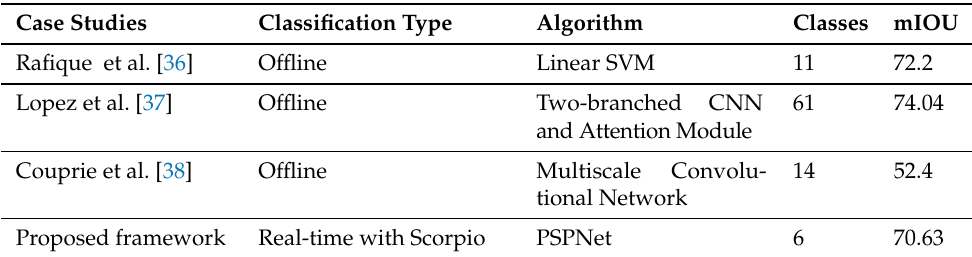
Table 6. Comparison with other existing